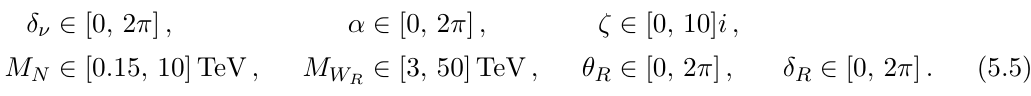
Figure 8. Scatter plot for the dependence of lepton asymmetry NH (left) and IH (right) cases. The blue (red) points are allowed (excluded) by the 0 (cid:23)(cid:12)(cid:12) decay constraint (see section